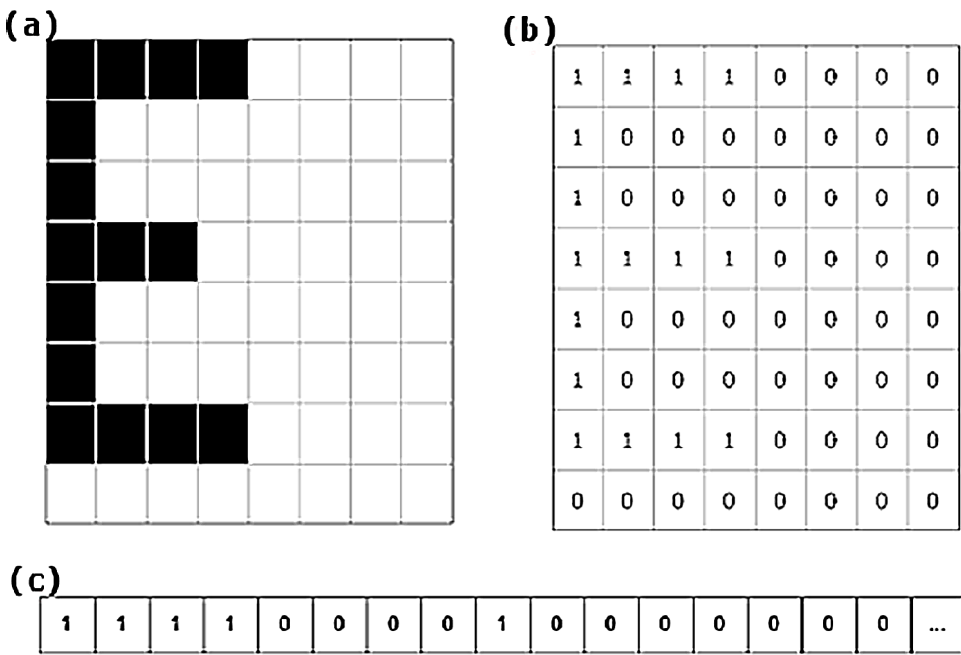
Figure 6. Representation of a morphology in three parts. In ( a ) we have a synthetic example of a binary form. In ( b ) a matrix of zeros and ones that corresponds with ( a ). In ( c ), the matrix ( b ) arranged as a vector which is how MONICOD works internally. This last representation is called a template.